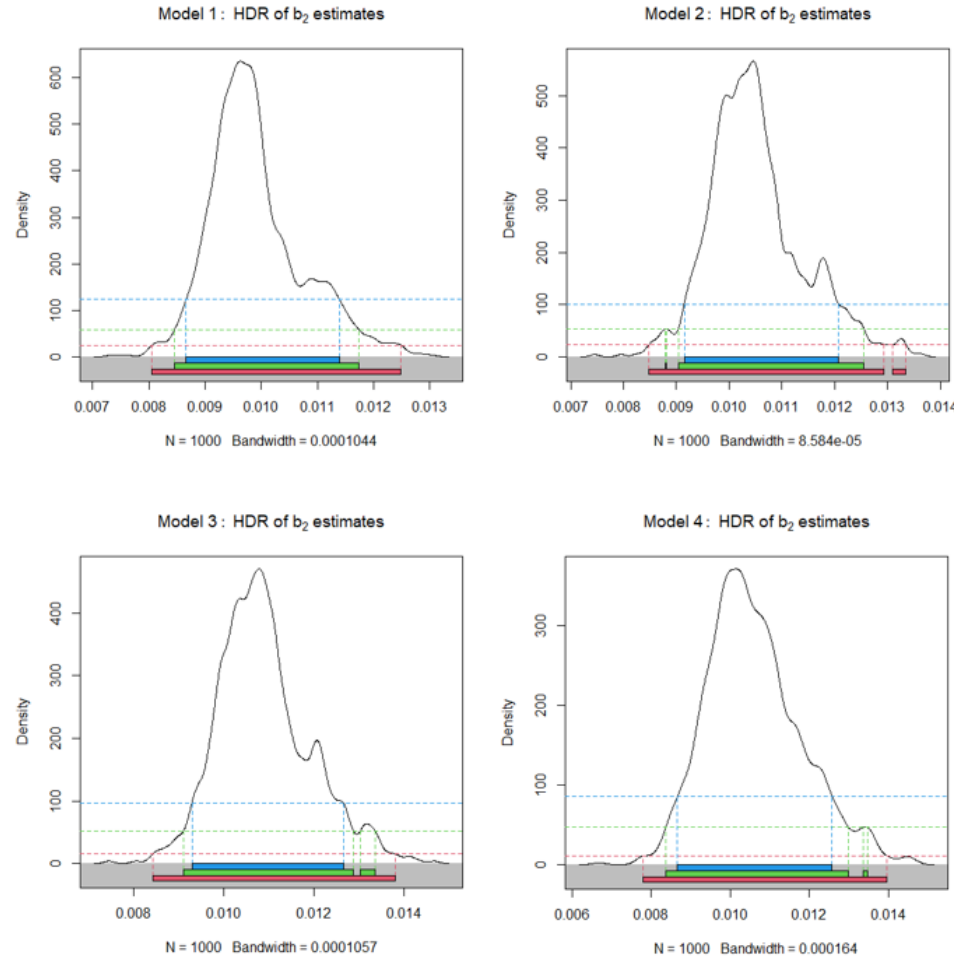
Figure 3. HDR of 𝑏 2 estimates. Model 1 to Model 4 (data from 1990 to 2019).